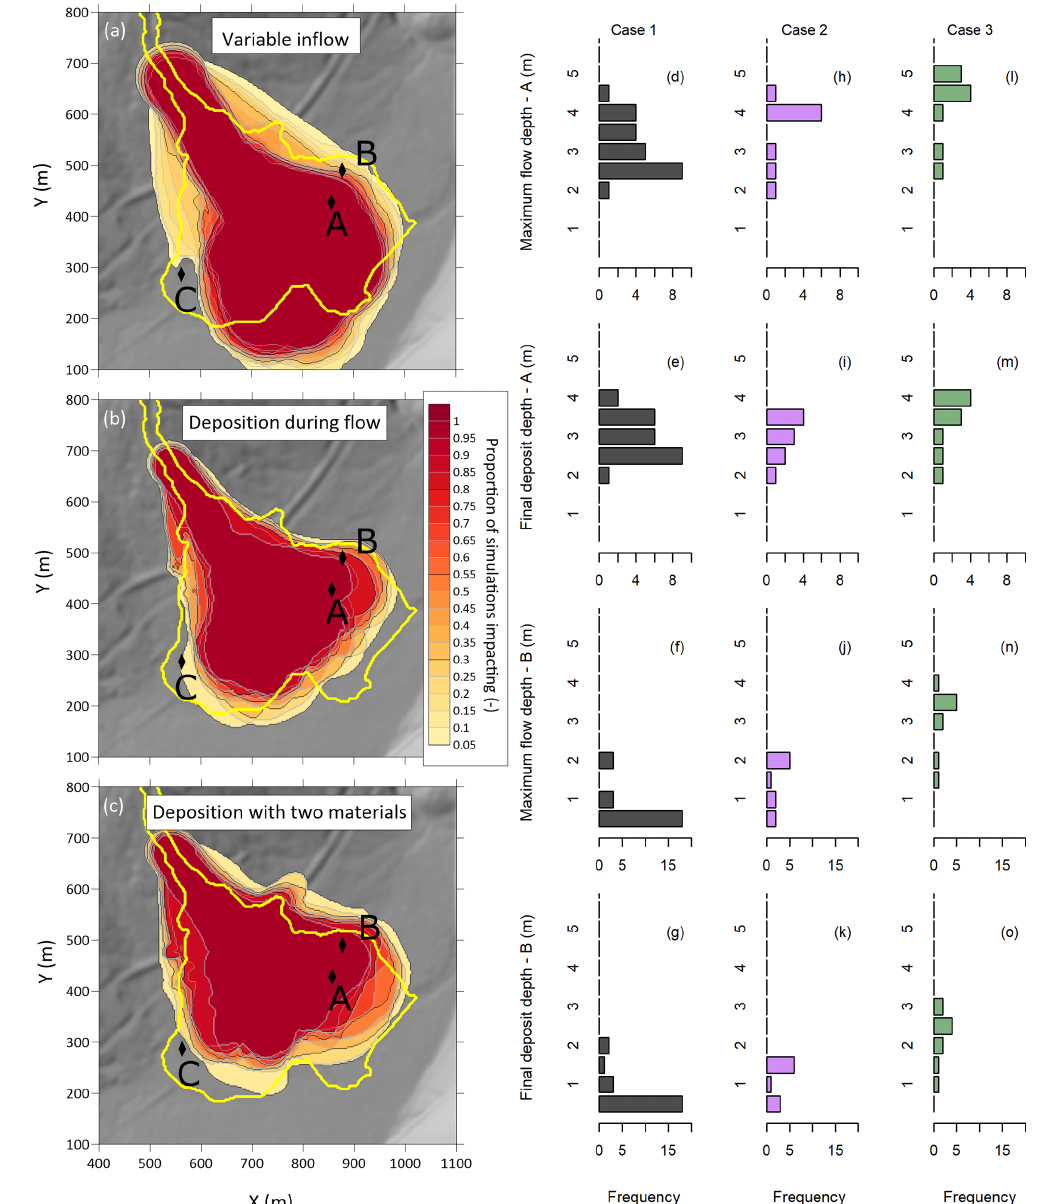
Figure 14. Variability in impact (a–c) and intensity (d–o) for the different Neff Creek simulations. The yellow outline on the impact pro- portion plots (a–c) indicates the observed impact area from the actual event. Topographic data derived from pre-event lidar data provided by BC Hydro. Results at Point C are not shown because the simulated maximum flow and final deposit depths were less than 0.5m for all